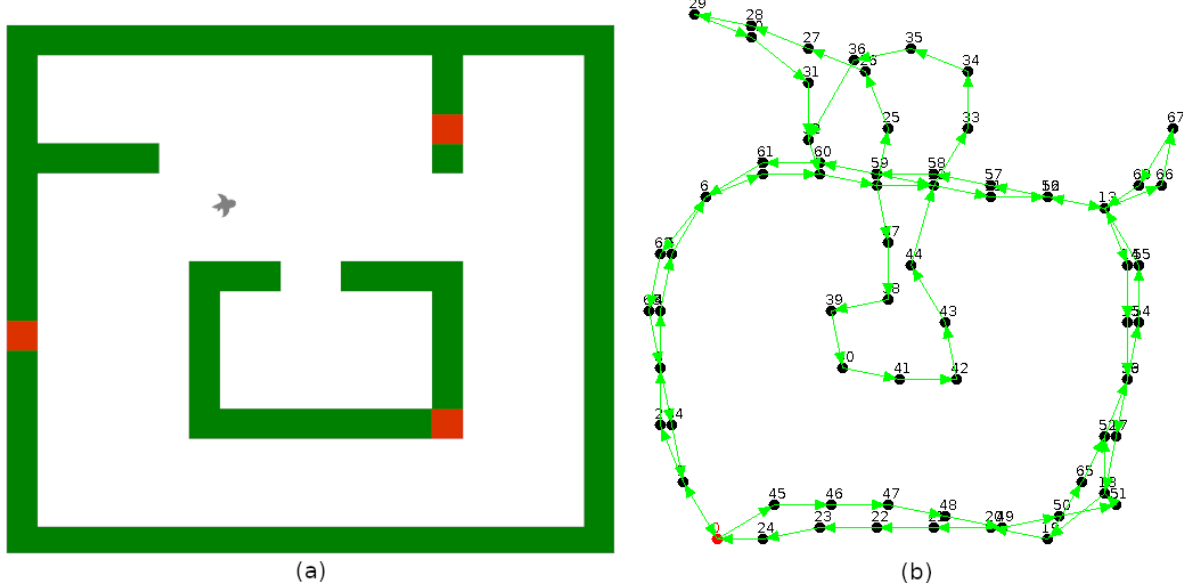
Figure 11. ( a ) the environment in which the test was conducted. ( b ) navigation graph obtained after covering the whole environment. The distances between place cells are computed in the grid cell module space, which do not exactly match physical